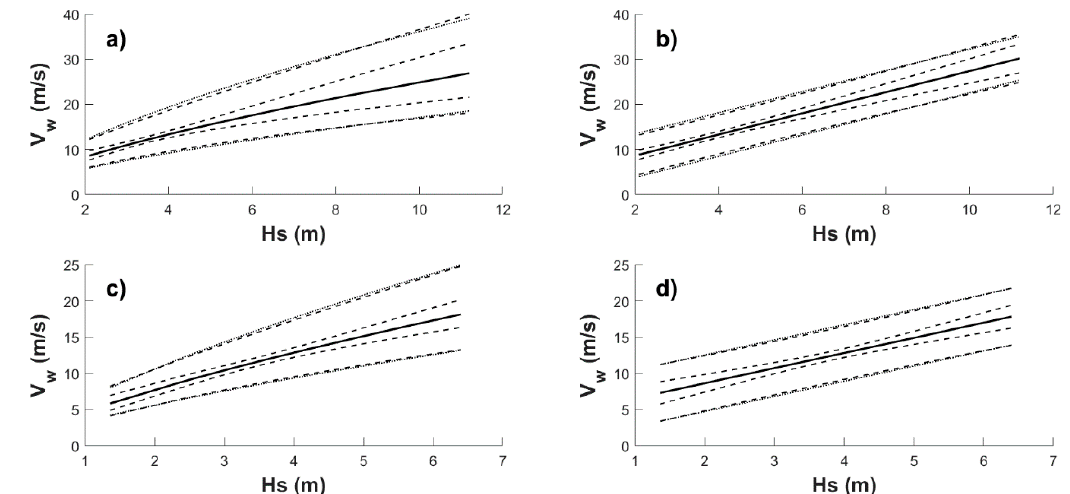
Figure 6. Comparison of exact and approximated (Equations (11) and (12)) 95% confidence intervals, considering October (upper row; ( a ) and ( b ) for non-linear and linear cases, respectively) and February (lower row; ( c ) and ( d ) for non-linear and linear cases, respectively).